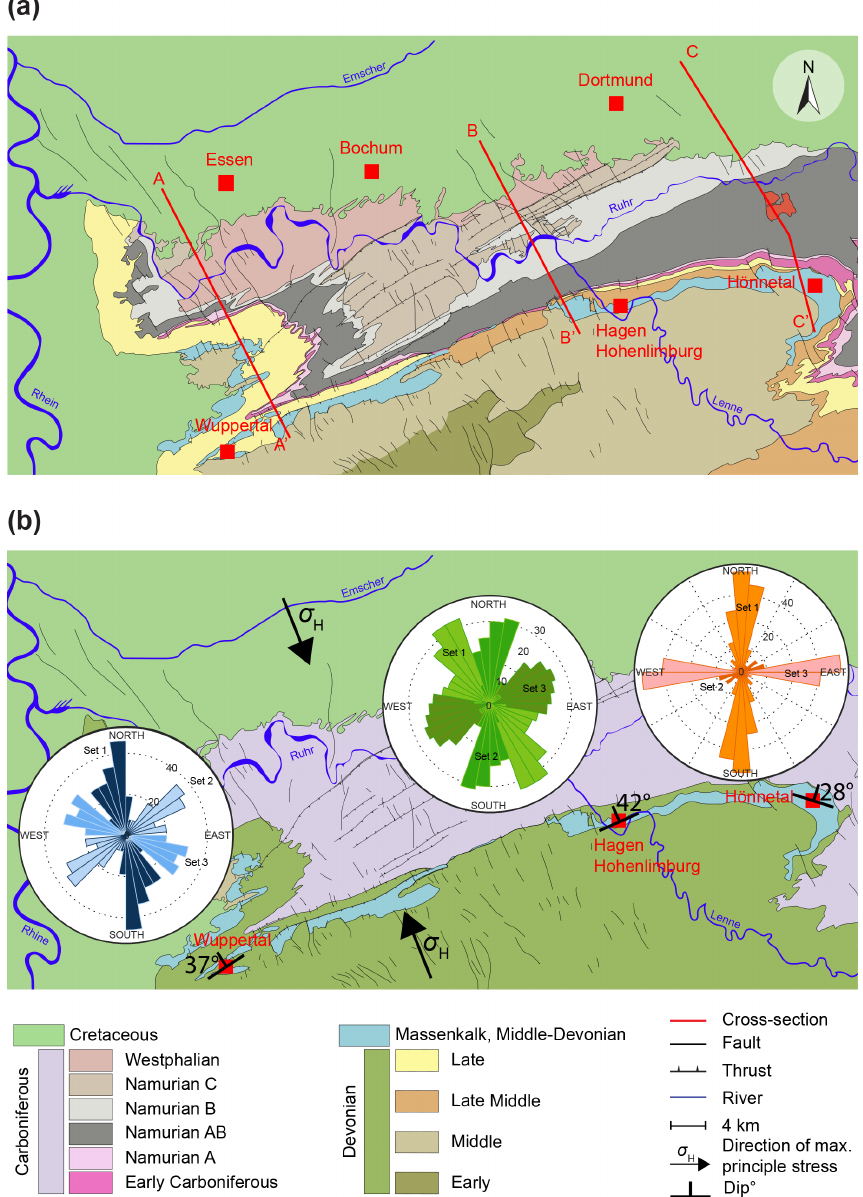
Figure 1. (a) Simplified geological map of the Rhine-Ruhr metropolitan area, Germany (modified from Jansen et al., 1986; Drozdzewski et al., 2007). Here, three stone pits have been chosen for field surveys: Osterholz (Wuppertal), Oege (Hagen), and Asbeck (Hönnetal), which are part of the Devonian Reef Complex (Massenkalk). The red lines indicate the three geological cross sections as shown in Fig. 2. In panel (b) , the geological map from panel (a) was further simplified, and in addition the rose diagrams of the discontinuity sets as measured by scanline investigations at the quarries in Wuppertal (blue), Hagen-Hohenlimburg (green), and Hönnetal (orange) are added (for more detail, see Figs. 4 to 6). The arrows indicate the direction of maximum horizontal stress σ H according to the World Stress Map (Heidbach et al., 2016). The specific directions and angles of incidence of the investigated, exposed limestone layers are also shown in panel (b)